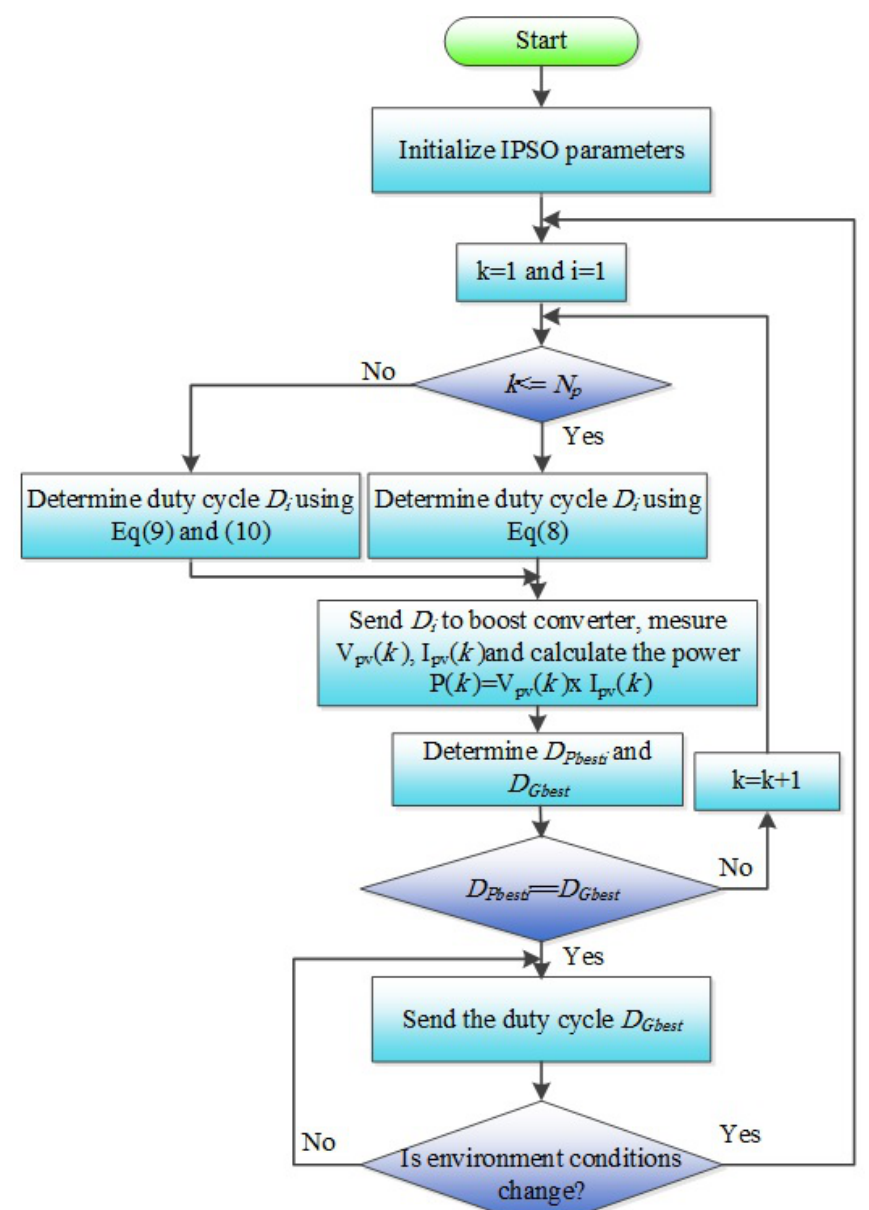
Figure 4. Flowchart of the Improved Particle Swarm Optimisation (IPSO)-based MPPT